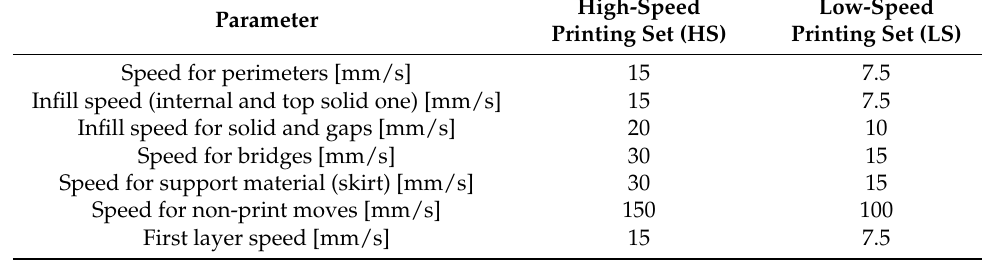
Table 2. Speed parameters of the two printing sets.